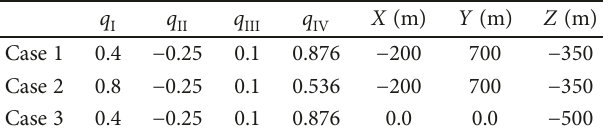
Figure 6: Diagram of the fi nal control Table 1: Initial state values for the numerical simulations.